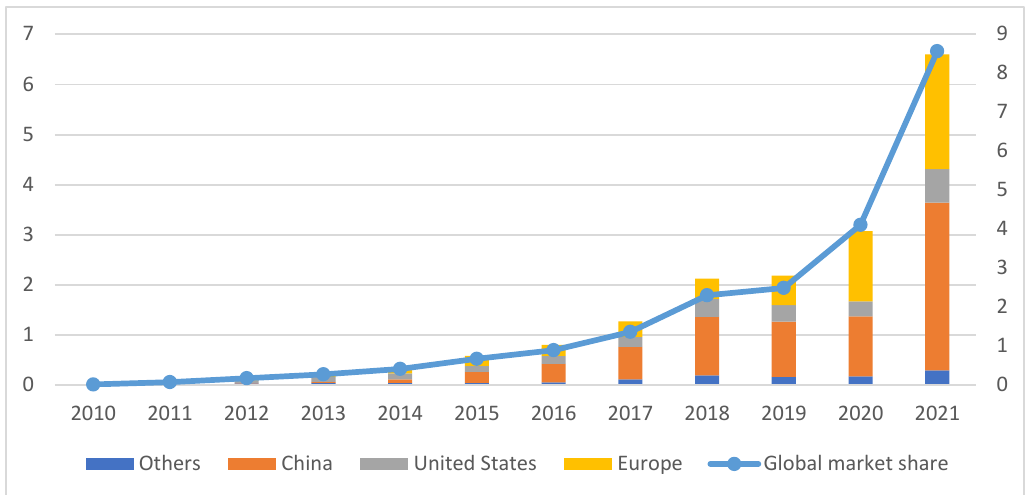
Figure 4. Electric vehicle sales and market share worldwide, 2010–2021.